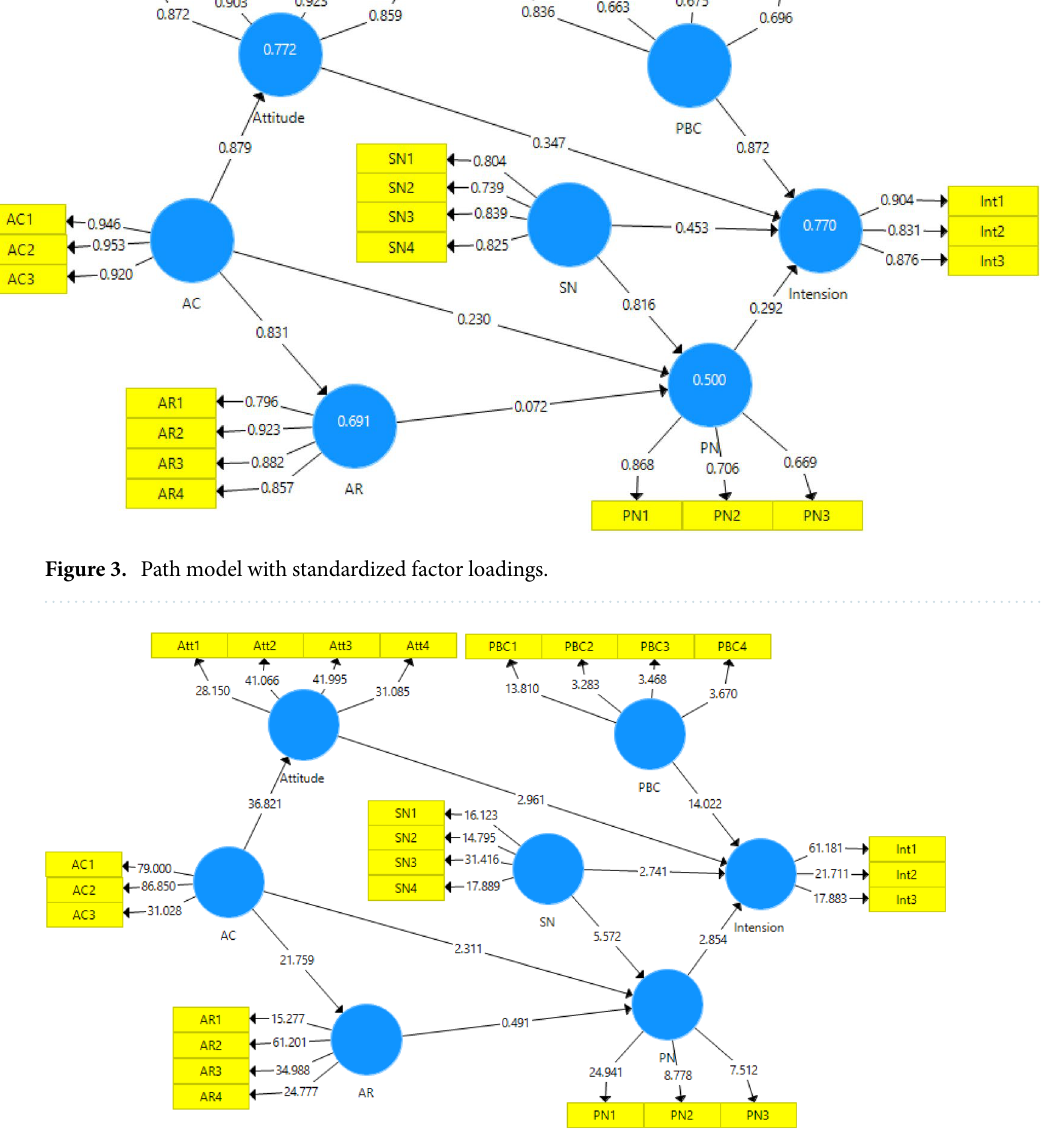
Figure 4. Path model with t -values.